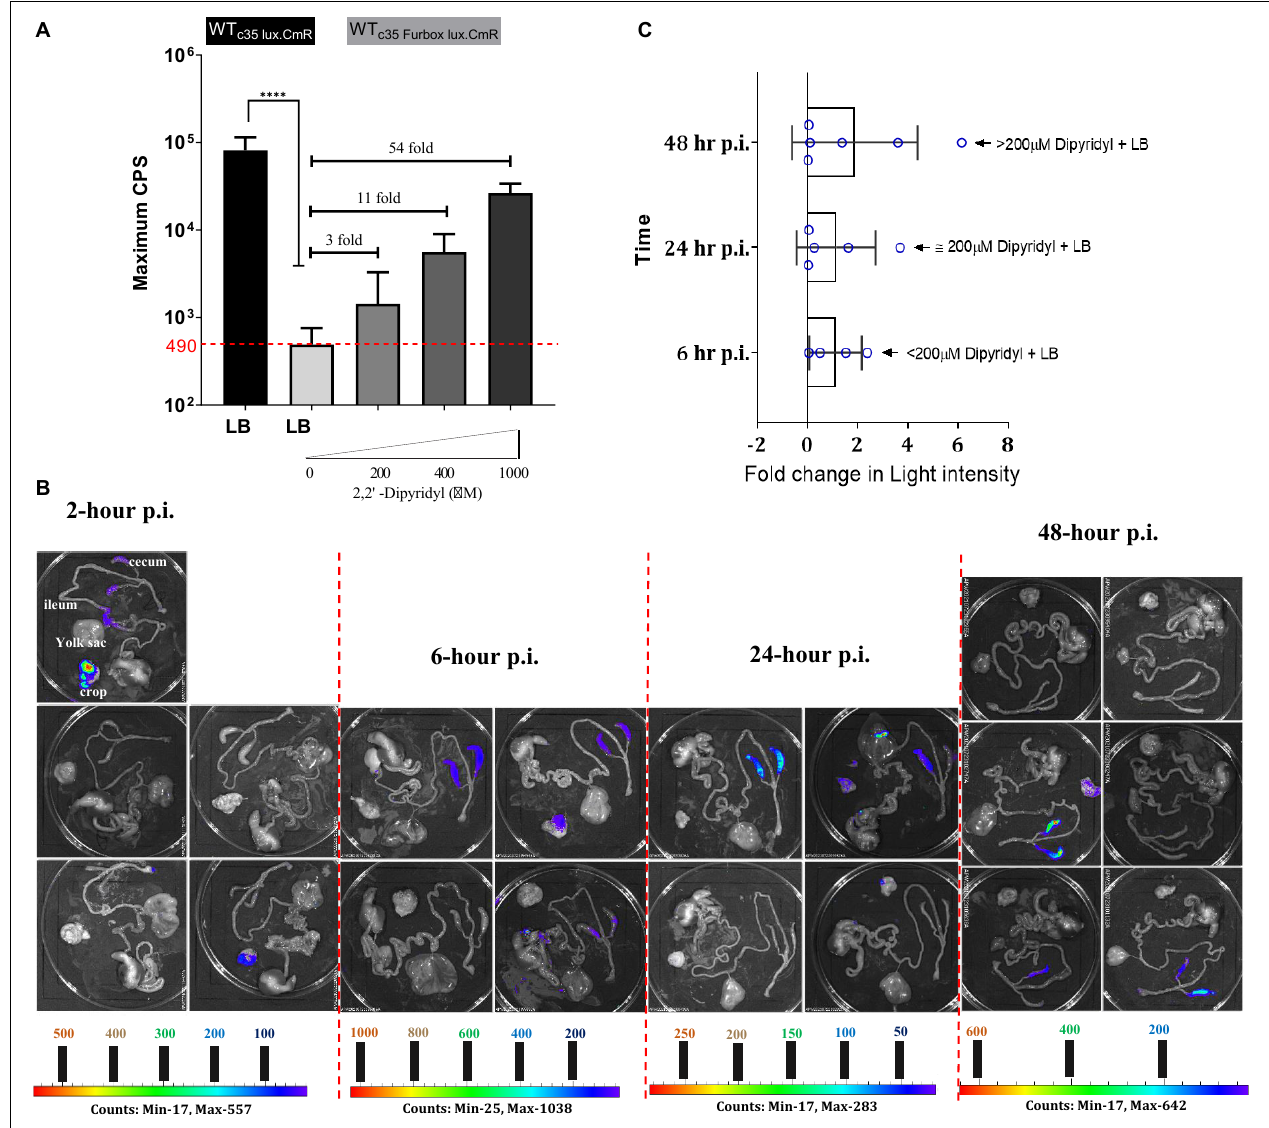
FIGURE 8 | (A) Fur box reporter (WT c 35Furboxlux . CmR ) expression under iron replete and iron deplete conditions. Maximum light intensity was obtained from luciferase assay results from 24 biological replicates run by a plate reader. 2,2 (cid:48) Dipyridyl (DP) used with varying concentrations to chelate iron in the LB. Fold change is calculated relative to the average value of reporter expression by the WT c35Furboxlux . Median of the data (CPS) was compared for statistics. ∗∗∗∗ P ≤ 0.0001. (B) Bioluminescent imaging of gastrointestinal tract of SPF birds challenged with reporter WT c35Furboxlux . CmR ). Lowest to highest signal intensity is shown in rainbow color scale. Each pixel represents a specific signal intensity. All images were taken at the IVIS settings of; f = 1, binning = medium, exposure = 60 s, filter = open. (C) Estimated Fur-mediated de-repression in the cecum as a fold change in light intensity. Fold change was calculated from dividing assigned light intensity for each cecal compartment, by 490 CPS. Maximum iron starvation at each time point has been indicated by means of iron chelation of in LB using